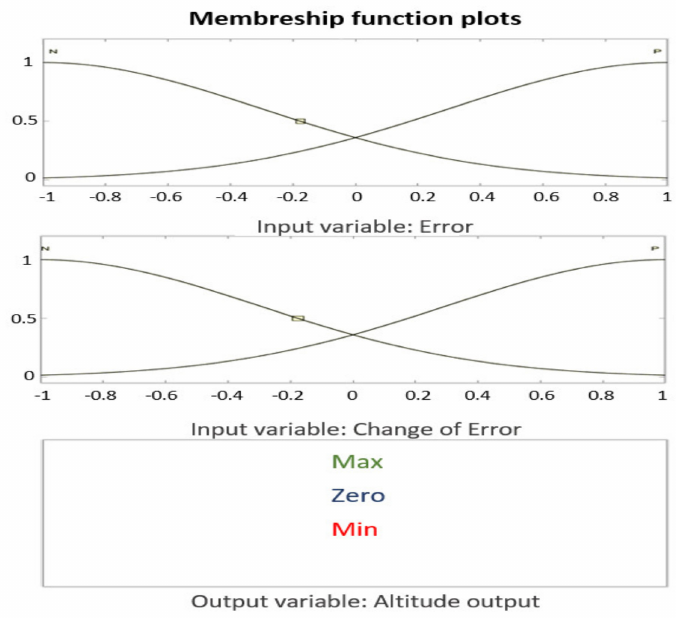
Figure 8. Sugeno membership